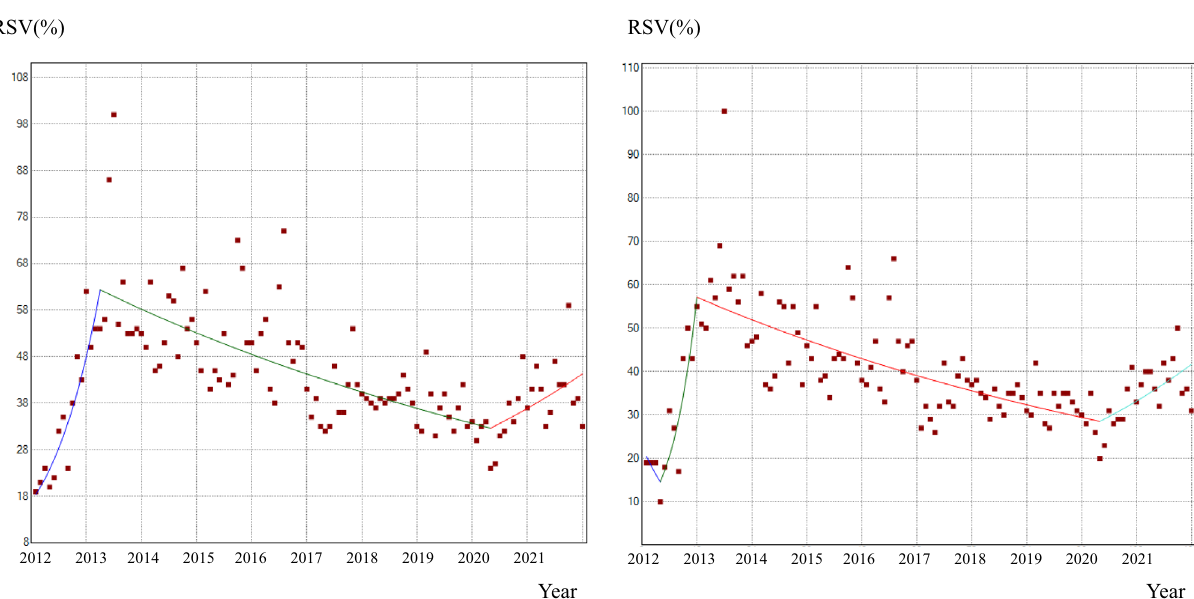
Figure 2. Monthly trends of RSV for “Shikyuu-keigan” in Google Trends by 2012 to 2021, by joinpoint analysis and search category. ( A ) In the “All” category, two joinpoints were observed in March 2013 and April 2020. ( B ) In the “Health” category, three joinpoints were observed in April 2012, December 2012, and April 2020. Details are given in Table 1.